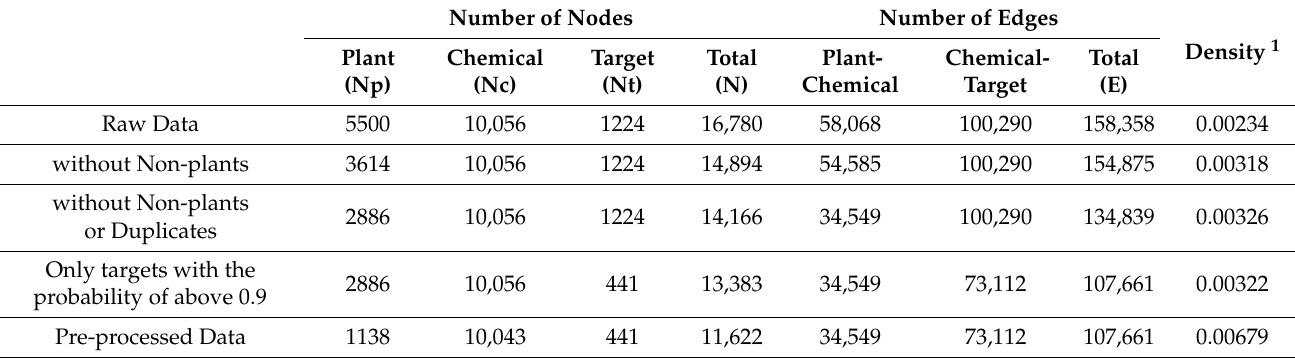
Figure 1. ( A ) The construction and visualization of the multipartite network database. ( B ) The representative multipartite network generated from the nodes which were randomly selected from 10% of the nodes 1138 plants, 10,043 chemicals, and 441 targets in the whole network. ( C ) The distribution of the node degrees for the plants, chemicals, or targets. Table 1. Basic statistic of the combined multipartite network